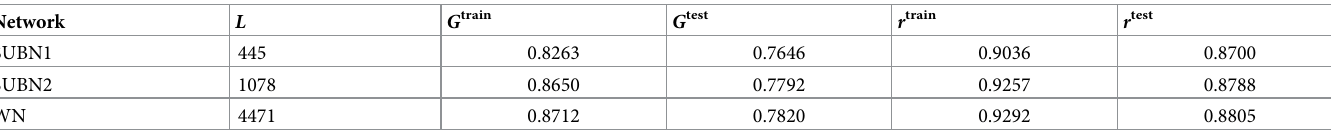
Table 1. Performance comparison between WN and the subnetworks.